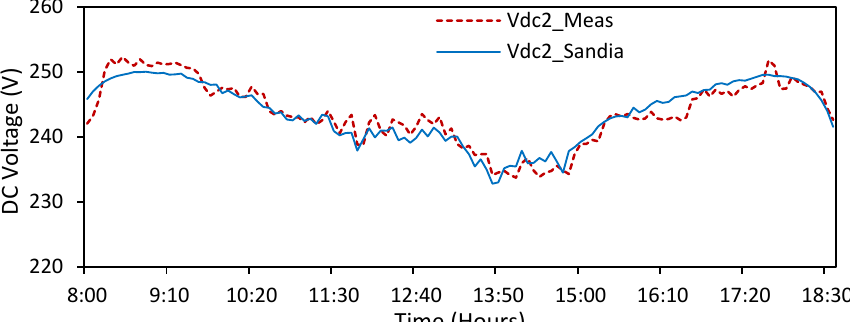
Figure 10. Measured and simulated MPP voltage of the PV subarray N ◦ 2. Table 9. Regression metrics of DC Voltage models simulated for three sub-arrays. Metrics/Param.